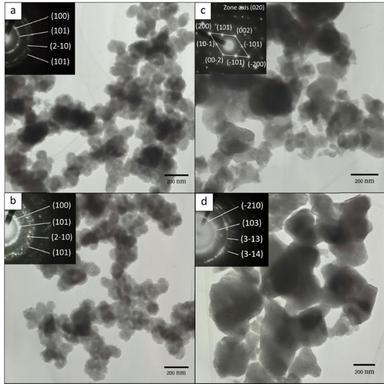
TEM images and selected area electron diffraction patterns of CdSggSe0.1. (a) CSS_An_500_5 ; (b) CSS_An_700_5 ; (c) CSS_An_700_10 and (d) CSS_An_900_5.